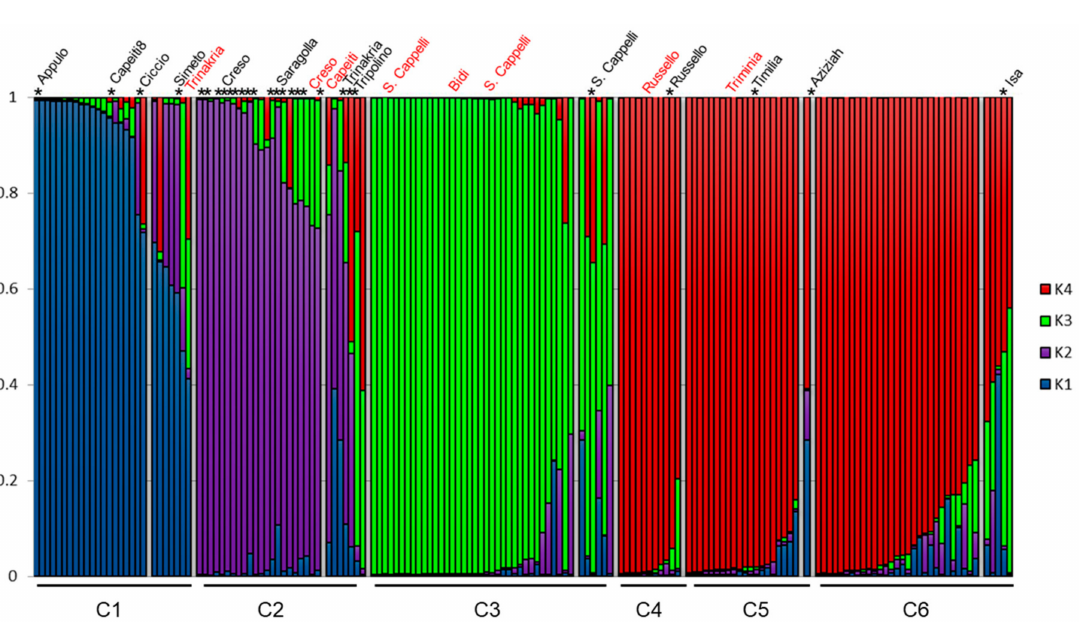
Figure 2. Population structure analysis for 136 accessions and 28 durum wheat varieties based on SSRs analysis. K-values of subpopulations are shown to right and accessions and varieties grouped according to the six clusters identified by DAPC are given below. Each individual is represented by a vertical line, and cluster assignments are indicated by color. Individuals are considered assigned to a cluster if their posterior probability in that cluster is at least 0.7. Varieties are indicated with a